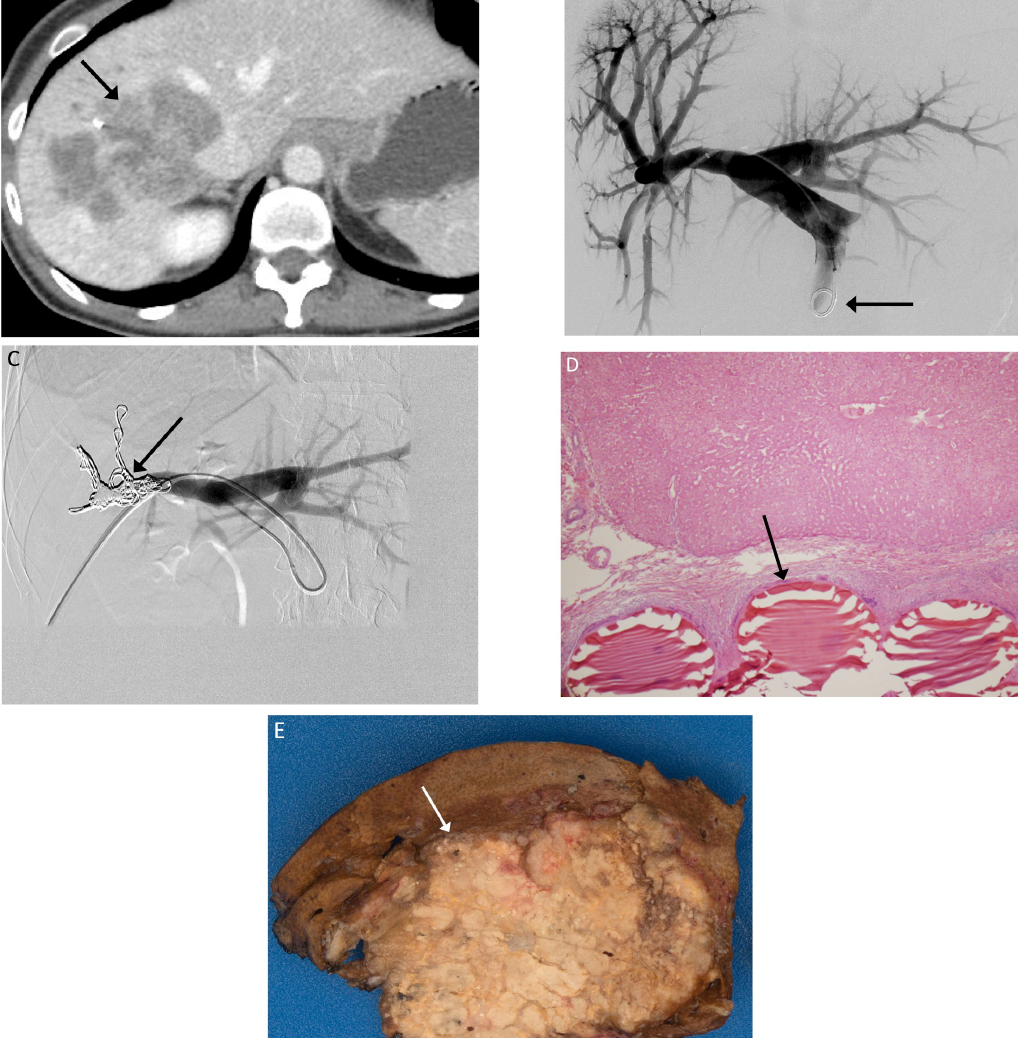
Figure 1. ( A ) Pre ‐ procedure CT imaging demonstrates a right hepatic metastasis (arrow) from colorectal cancer, with a diminutive left lobe; ( B ) Tranhepatic portography (arrow) is obtained after portal access is achieved via the right portal vein; ( C ) The right portal branches have been embolized with particles and metallic coils (arrow); ( D ) 200× magnification H&E stain slide demonstrates Embosphere particles within a portal vein (arrow); ( E ) Gross specimen after right hepatectomy demonstrates particles within the embolized right hepatic lobe. White bar indicates 5 cm.